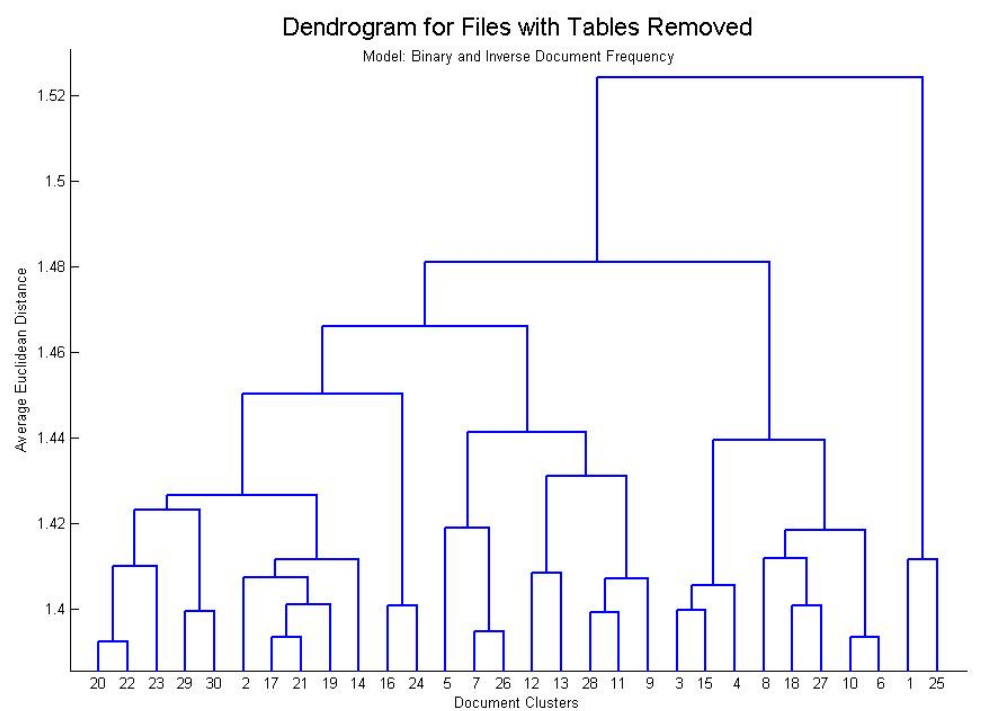
Figure 4. Agglomerative hierarchical clustering results for the Binary IDF Model when numerical words are not included; tables are removed in the top dendrogram and are included in the bottom